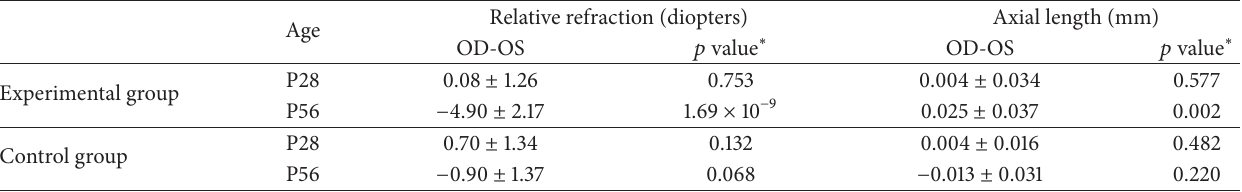
Table 3: Results of retinoscopy refraction and axial length measurements.